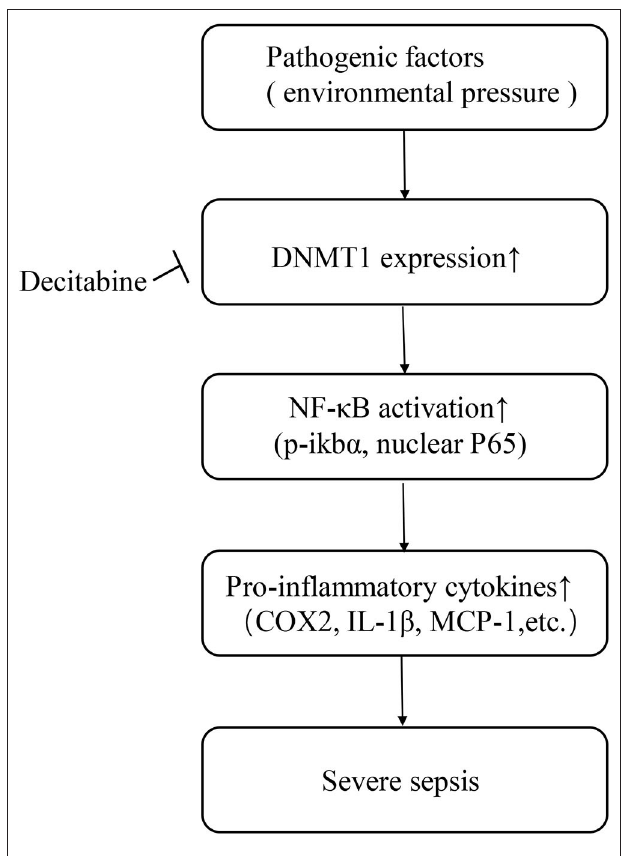
FIGURE 5 | Schematic of study.